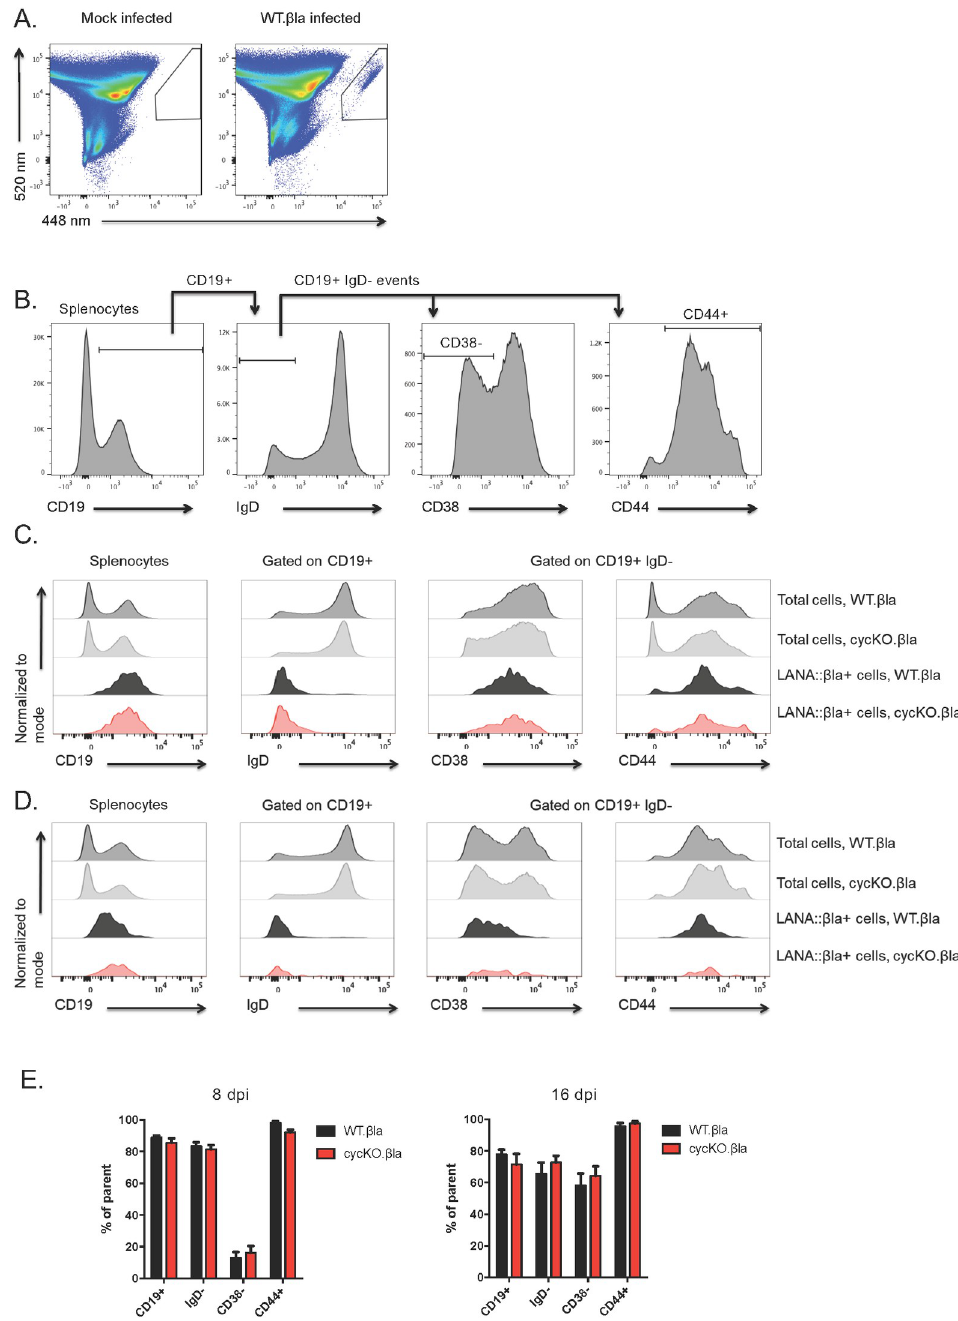
Fig 2. Cyclin deficient virus has a similar cellular distribution to wild-type γ HV68 during primary infection of C57BL/6J mice. Analysis of the cellular distribution of WT and cycKO γ HV68 infection in splenocytes from C57BL/6J mice at either 8 dpi (A-C, E) or 16 dpi (D, E), defined based on the distribution of LANA:: β la+ cells quantified by flow cytometric analysis. Representative gating of (A) LANA:: β la+ splenocytes and (B) B cell subsets, including identification of total B cells (CD19+), germinal center B cells (CD19+, IgD-, CD38-), and activated B cells (CD19+, IgD-, CD44+) at d8 post-infection. (C) and (D) representative histograms of cell surface marker expression after infection with WT. β la or cycKO. β la virus on total cells (dark grey WT. β la and light grey cycKO. β la), WT. β la infected LANA:: β la+ cells (black), or cycKO. β la infected LANA:: β la+ cells (red), at either 8 dpi (C) or 16 dpi (D). (E) Quantification of the frequency of cells expressing cell surface markers using the gating strategy outlined in (B) with SEM shown, at either 8 dpi (left) or 16 dpi (right). All populations identified were CD19+ B cell subsets; IgD- refers to the frequency of CD19+ B cells that were IgD-; CD38- refers to the frequency of CD19+ IgD- B cells that were CD38 negative; CD44+ refers to the frequency of